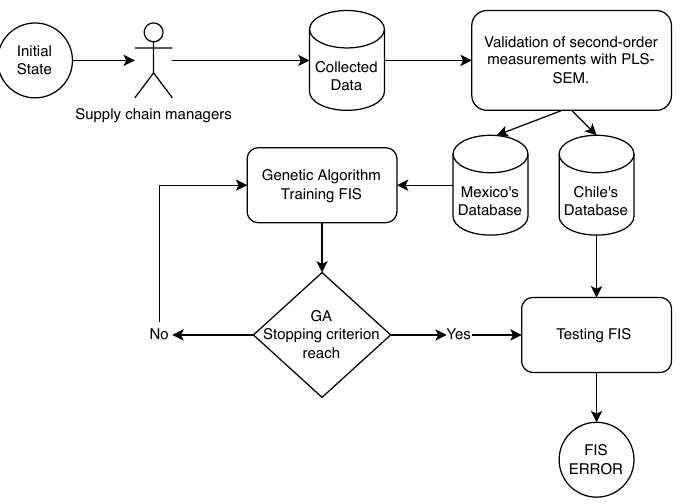
Figure 1. The diagram of the methodology employed in this